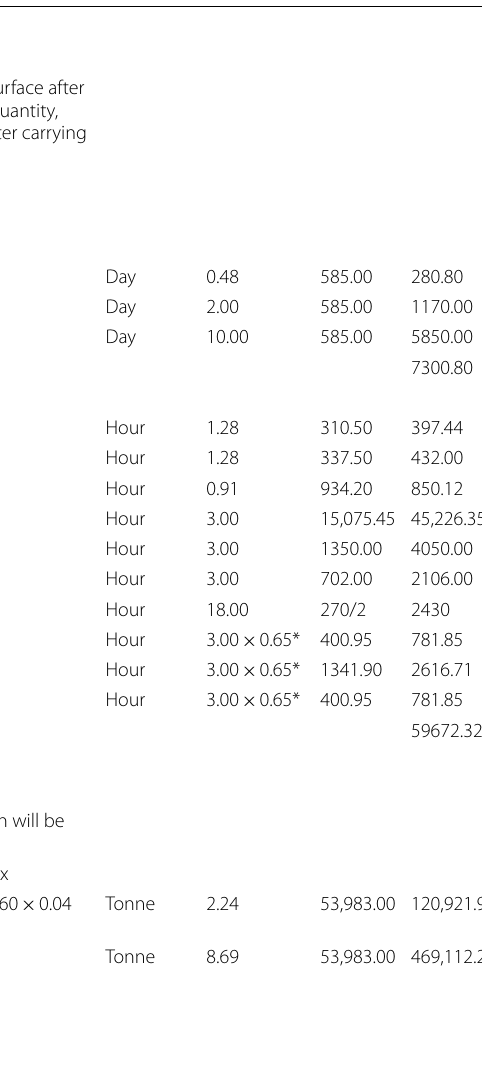
Table 7 Cost analysis of DBM with RAP aggregates Analysis for recycling of Bituminous pavement by Milling (DBM) (below 80 mm) S. no. Description of